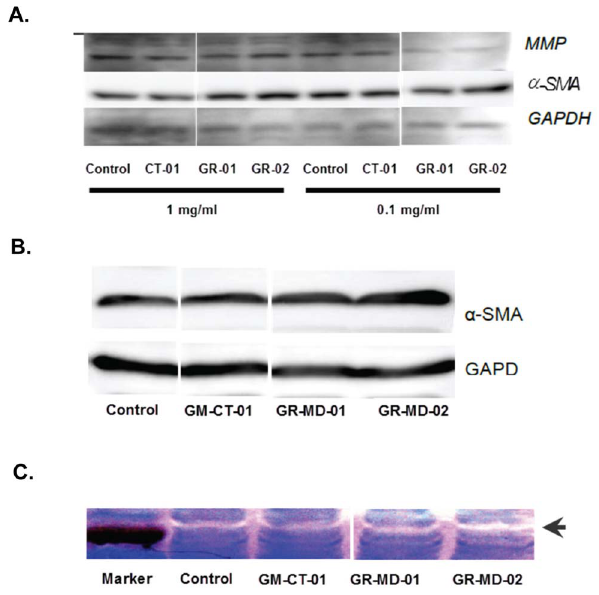
Figure 13. Protein expression and gelatinase activity in stellate cell cultures. Samples were all analyzed on same gel or autoradio- graph; discontinuity on the figures is due to the removal of repeated samples of different lots of GM-CT-01 which gave same results. A : Western blot analysis of protein isolated from cultures of LX-2 cells. MMP2=metal metalloprotease 2; a -SMA=alpha smooth muscle actin; GAPDH was used as an internal control. CT-01=GM-CT-01; MD-01=GR- MD-01; MD-02=GR-MD-02. B : Western blot analysis of protein isolated from cultures of primary human stellate cells. a -SMA=alpha smooth muscle actin; GAPDH was used as an internal control. All drug concentrations were 1 mg/ml and evaluations were performed 24 hours following addition of drug. C : MMP2 activity by zymography. MMP-2 enzymatic activity in LX-2 was determined using 10% Zymogram (Gelatin) gel (10% Tris-Glycine gel with 0.1% gelatin substrate). Gelatinases present in the cells degrade the gelatin matrix, leaving a clear band (arrow) after staining the gel for protein. Drugs were administered to cells at 0.1 mg/ml for 24 hours.